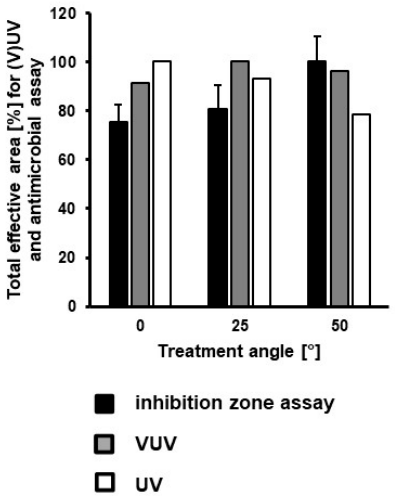
Figure 12. Total effective area depending on incidence angle (0°, 25°, 50°) with kINPen ® MED- β for the inhibition zone assay (after 45 s treatment; Staphylococcus aureus DSM 799/ATCC 6538, M ± SD, n = 6) as well as VUV and UV.